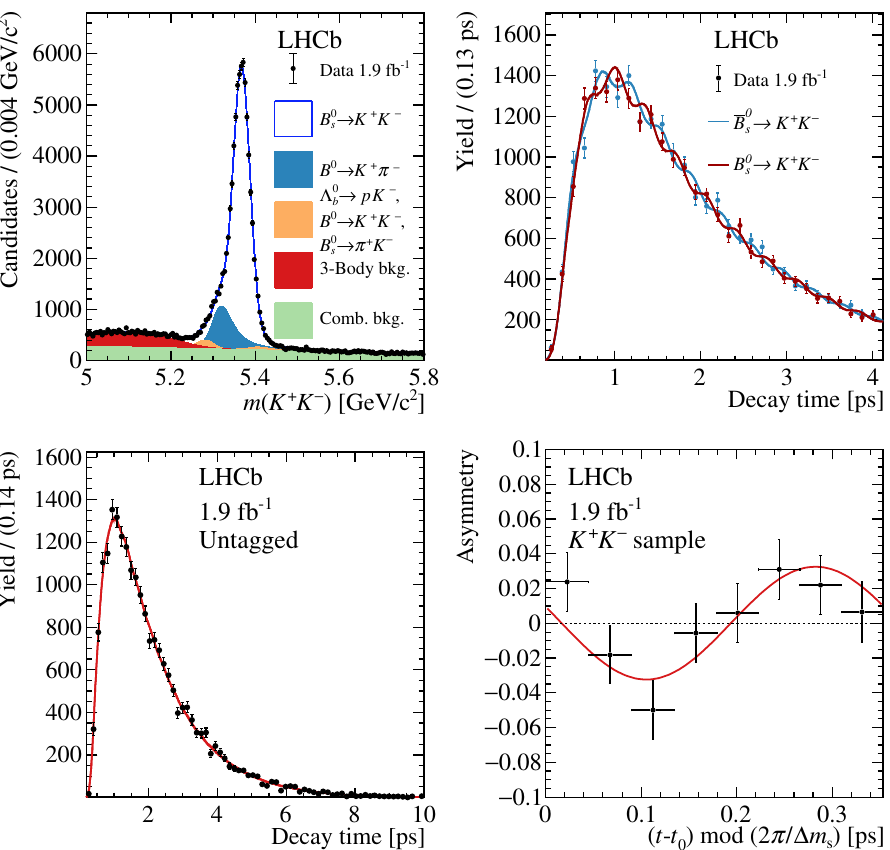
Figure 8 . Distributions of the K + K (cid:0) invariant mass (top left), decay time for tagged B 0 mesons s (top right), decay time for untagged B 0 candidates (bottom left) and asymmetry (bottom right) for s the B 0 K + K (cid:0) decays. The individual components are shown for the invariant mass spectrum s ! while only background-subtracted candidates are shown in the decay time spectrum. The (cid:12)t results to the di(cid:11)erent distributions are overlaid. The various components contributing to the invariant mass model are drawn as stacked histograms. The asymmetry for the K + K (cid:0) candidates is folded into one mixing period 2 (cid:25)= (cid:1) m s and the parameter t 0 = 0 : 2 ps corresponds to the minimum value of the decay-time used in the